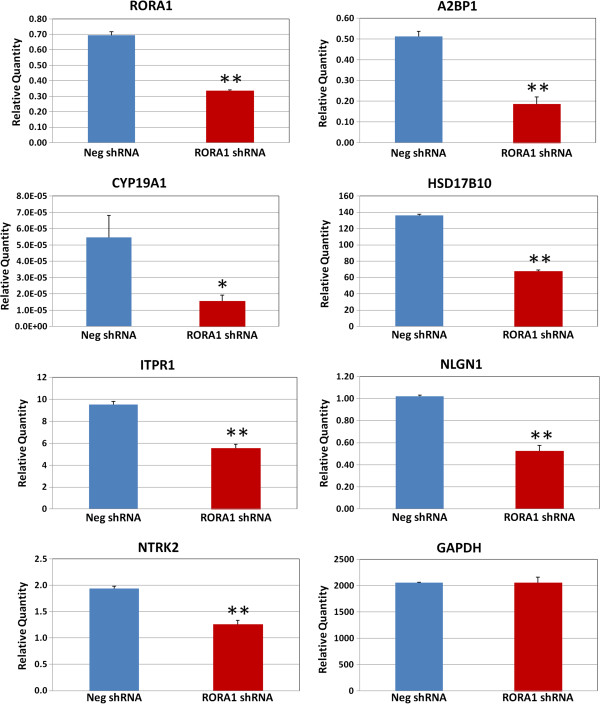
Quantitative RT-PCR analysis of RORA short hairpin RNA-transfected SH-SY5Y cells. SH-SY5Y cells were transfected with RORA1 short hairpin RNA (shRNA) or negative control shRNA for 24 hours and quantitative RT-PCR analysis (n = 3) was performed to determine expression of RORA1 and potential transcriptional targets in the transfected cells. GAPDH was included as a negative control. Error bars indicate standard error of the mean. *P <0.05, **P <0.01.